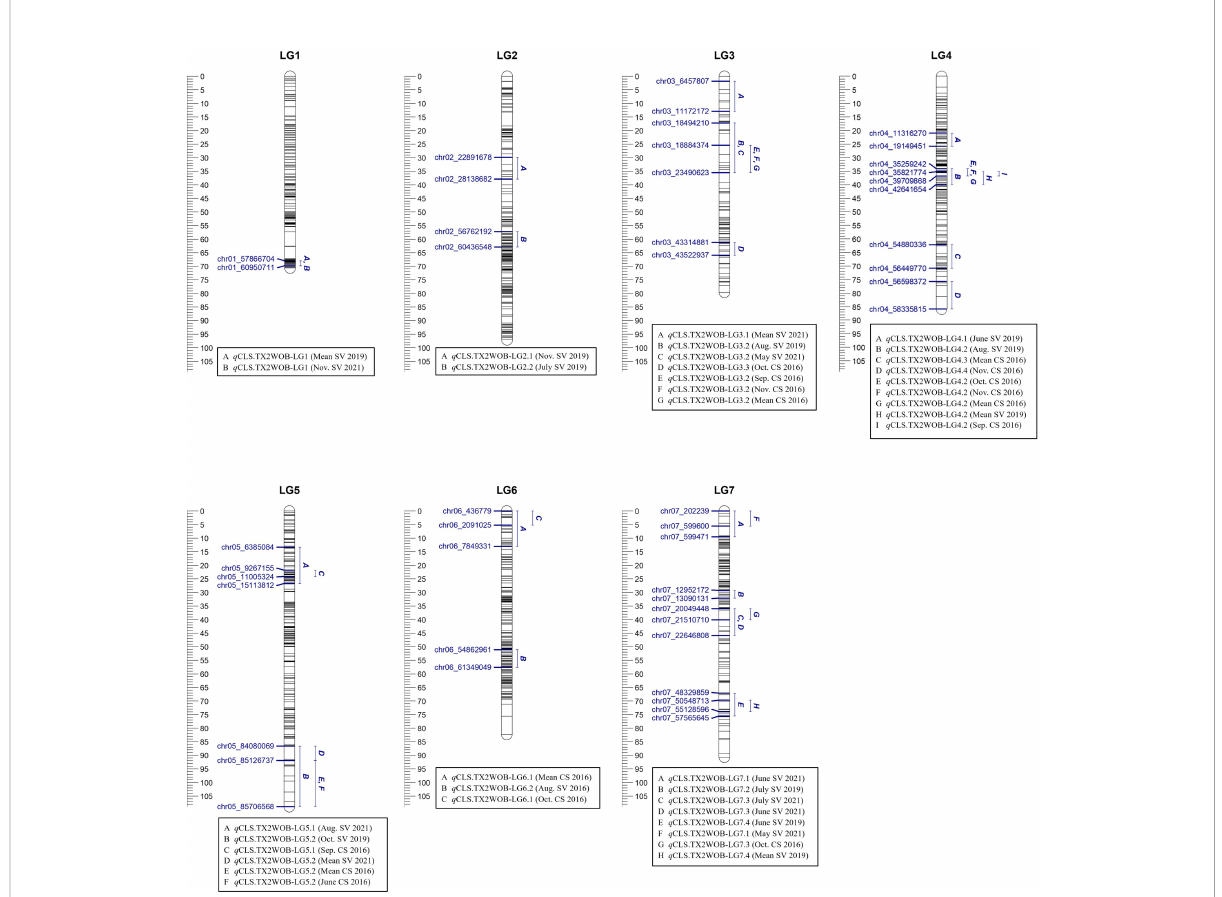
FIGURE 1 Positions of putative QTLs controlling the cercospora leaf spot disease (CLS) incidence across 11 diploid rose populations at linkage groups (LG) of the fi ve-population (TX2WOB) consensus map. QTL names are listed below each LG. The plot generated using MapChart